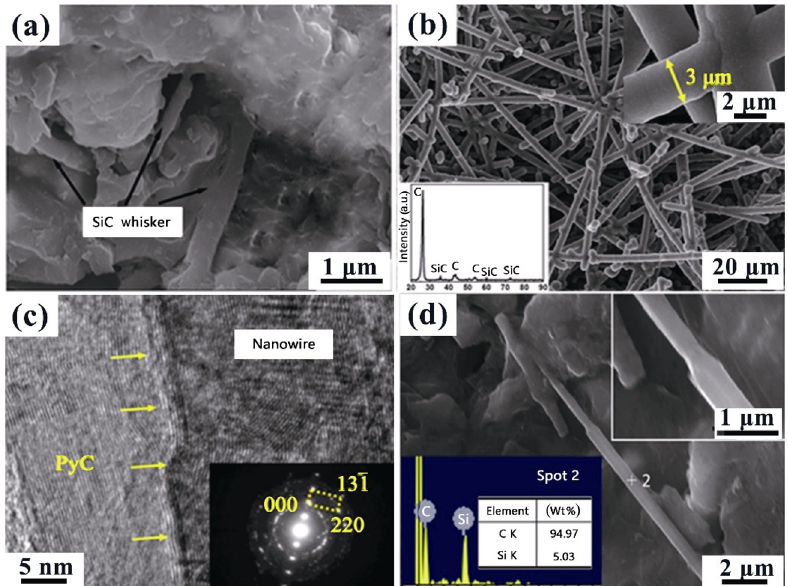
Fig. 35 Typical nanostructures used for UHTC coating toughening: SiC whiskers in the HfB 2 –SiC–Si/SiC coating [318] (a), SiC/PyC core–shell nanowires [354] (b, c), and SiC/PyC core–shell nanowires in the TaB 2 –SiC coating [355] (d). Reproduced with permission from Ref. [318], © Elsevier Ltd and Techna Group S.r.l. 2018; Ref. [354], © The American Ceramic Society 2018; Ref. [355], © Elsevier Ltd.